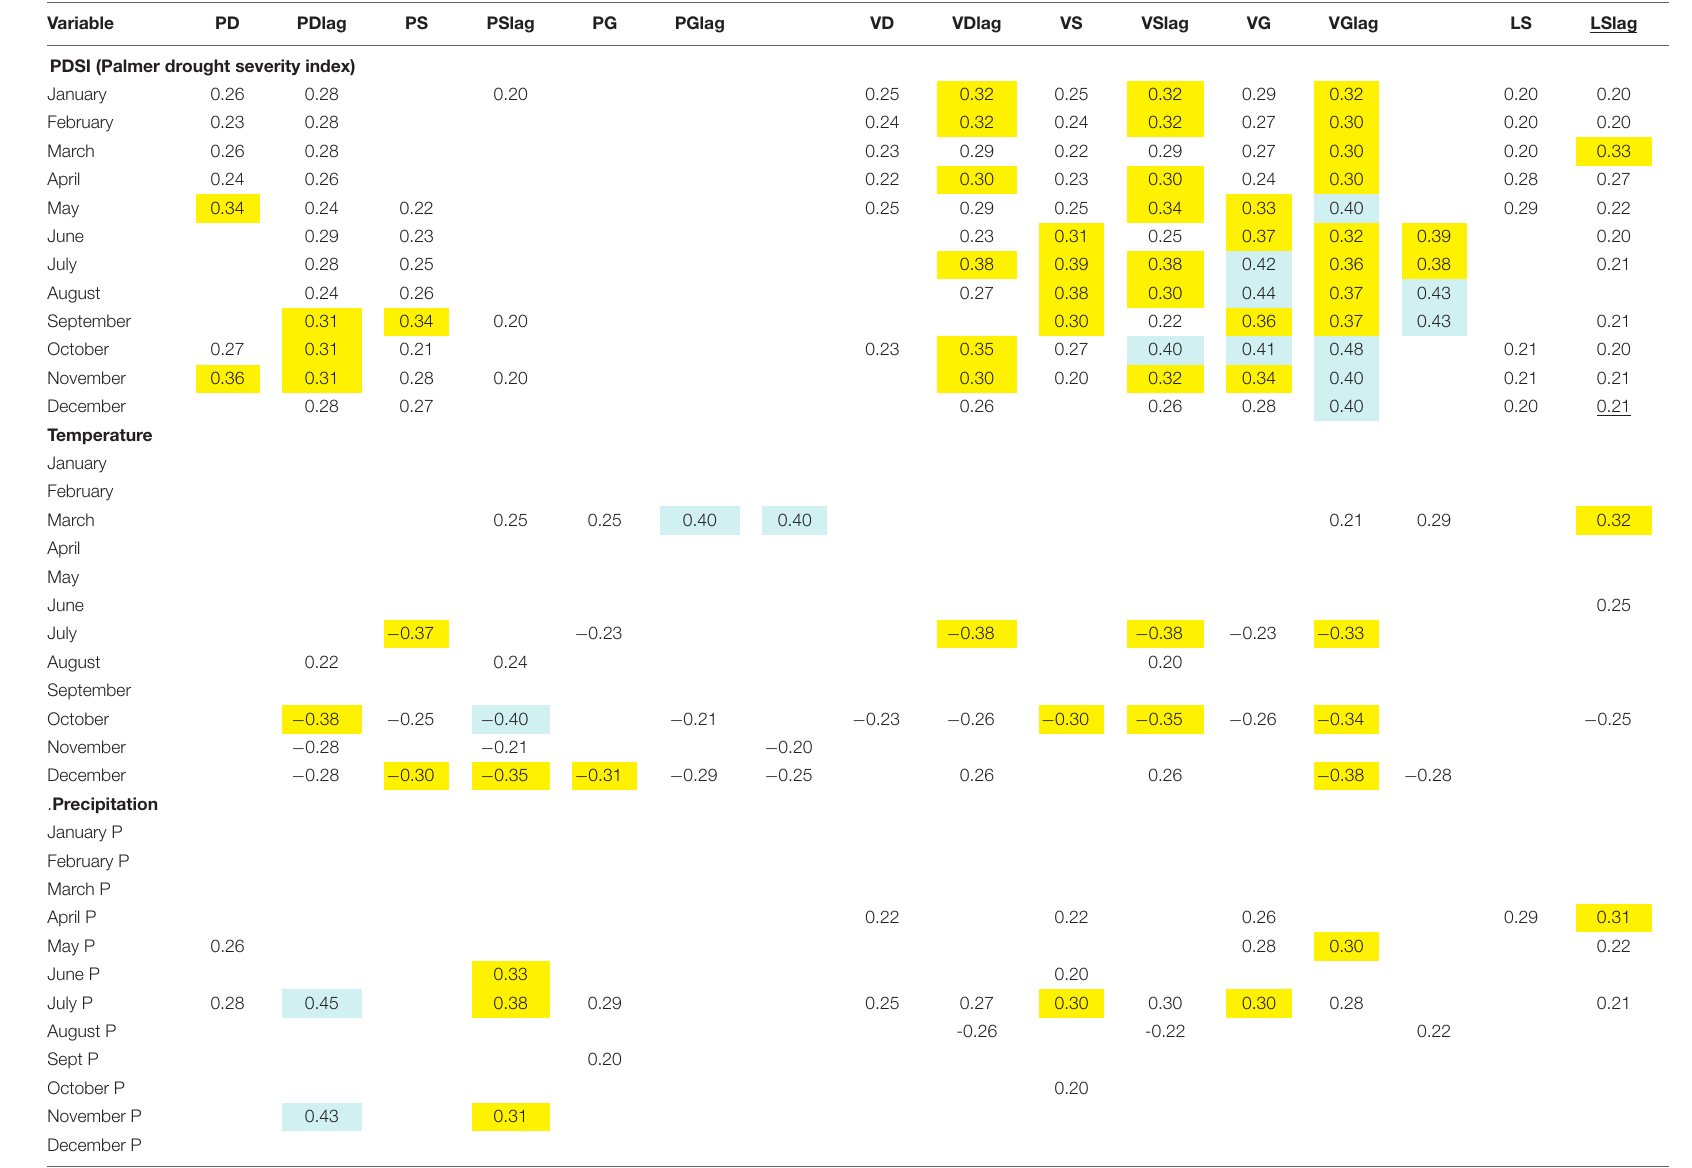
TABLE 8 | Pearson product correlations of climate variables for same year and lagged 1 year (lag) with mean basal area increment (BAI)/basal area (BA) for Pinus albicaulis from 1950 to 2005 at three sites.